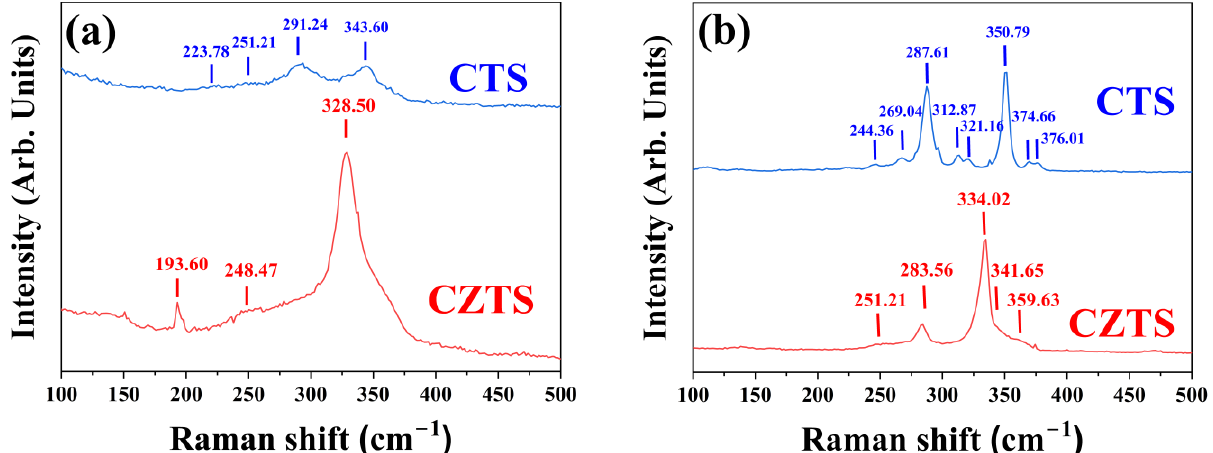
Figure 3. Raman spectra collected with a 488 nm laser on as-milled ( a ) and thermally treated ( b ) samples of CTS and CZTS. The samples in ( a ), in the disordered cubic phase, display significantly broader peaks than the ordered (monoclinic CTS and tetragonal CZTS) phases in ( b ). This is believed originating from cation disorder itself, likely causing variable coordination environments and inhomogeneous bonds, leading to a spread in vibrational modes.